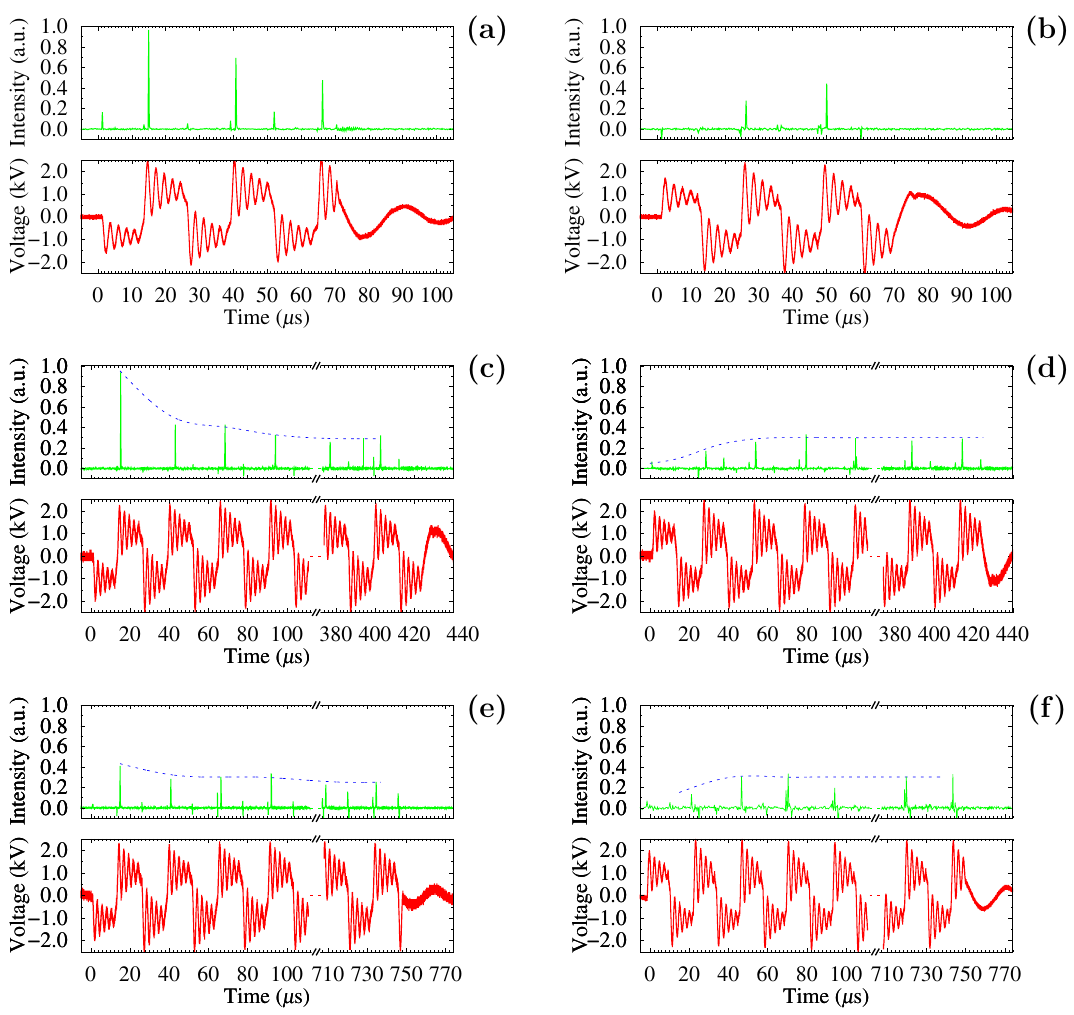
Figure 5. Light intensity at 706.5 nm (green lines) and voltage signal (red lines): (i) at the duty cycle of ≈ 8 % for the first negative ( a ) and positive ( b ) pulses in the bunch; (ii) at the duty cycle of ≈ 50 % for the first negative ( c ) and positive ( d ) pulses in the bunch; (iii) at the duty cycle of ≈ 90 % for the first negative ( e ) and positive ( f ) pulses in the bunch. The signals were recorded with 50 accumulations. The time scale is chosen to represent one full bunch of the applied voltage. (B)(A)